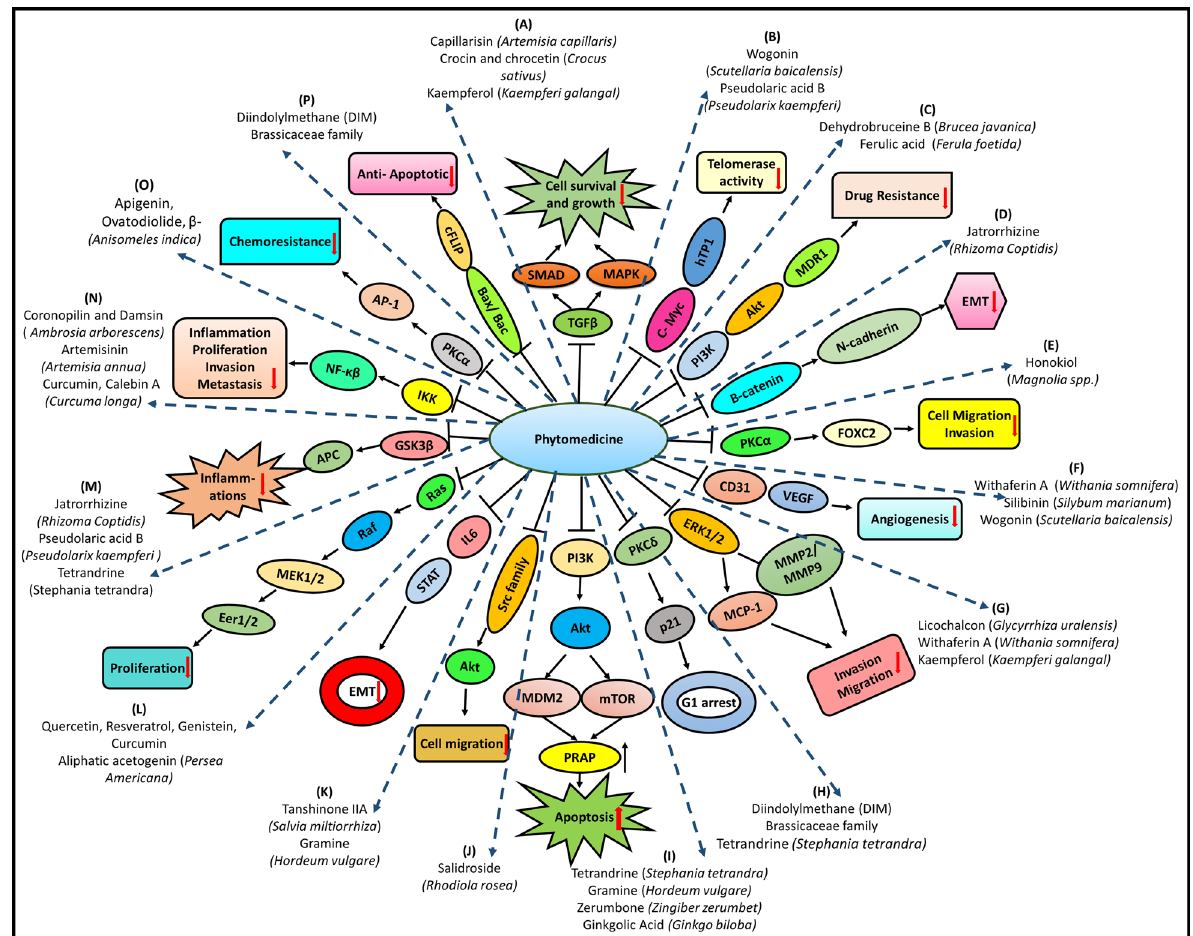
Fig. 2 Schematic diagram of different cancer cell survival signaling pathways targeted by various phytomedicinal compounds. Origin of the dotted arrow and the particular pathway being targeted by phytocompounds coincides at the center. a [137–139], b [140, 141], c [142, 143], d [144], e [145], f [141, 146, 147], g [137, 147, 148], h [103, 149], i [149–152], j [153], k [150, 154], k [78], l [140, 144, 149], m [120, 123, 155], n [113, 156], o [103], p